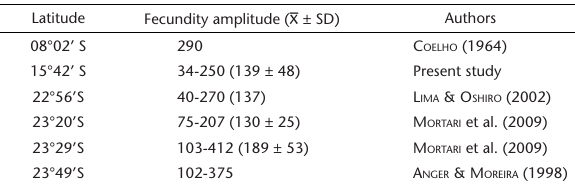
Table 2. Comparison of fecundity in Palaemon pandaliformis between studies from different